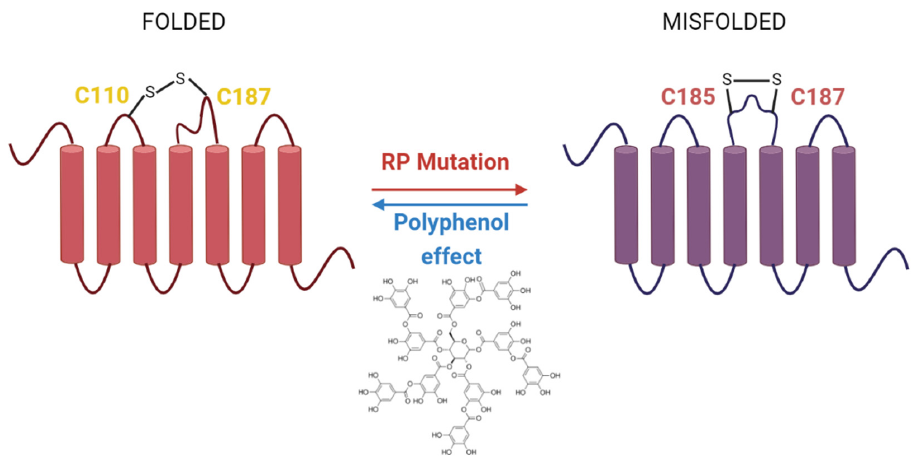
Figure 4. RP mutations and polyphenol effects on Rho conformation. RP mutations can cause misfolded proteins due to abnormal disulfide bonds. In contrast, polyphenols can counteract this effect and fold the protein correctly, thus allowing proper and efficient activity.